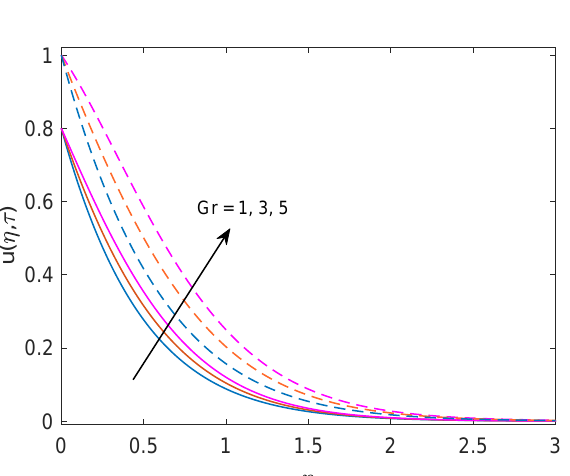
Figure 2. Velocity comparison.